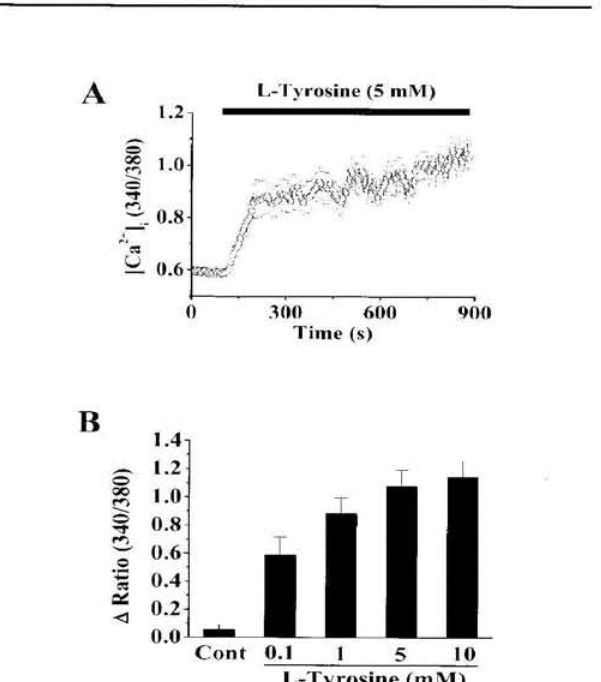
Figure 1 L-Tyrosine-induced [Ca 2l ]¡ elevation in HIT- T15 cells. Cytosolic Ca 2 was measured using fura-2 as a Ca 2